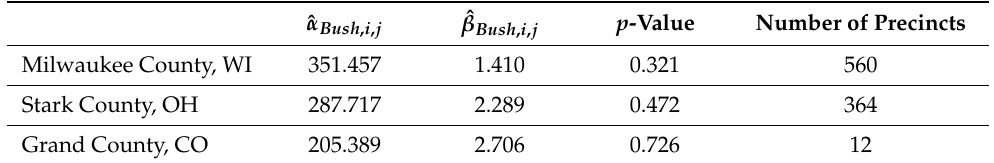
Table 3. Maximum Likelihood Estimates and Goodness of Fit Test Results for Vote Counts for Selected Counties in 2004 US Presidential Election—President George W. Bush. p -values above 0.05 (plotted in blue) indicate conformance to discrete Weibull distribution. ˆ α Bush , i , j ˆ β Bush , i , j p -Value